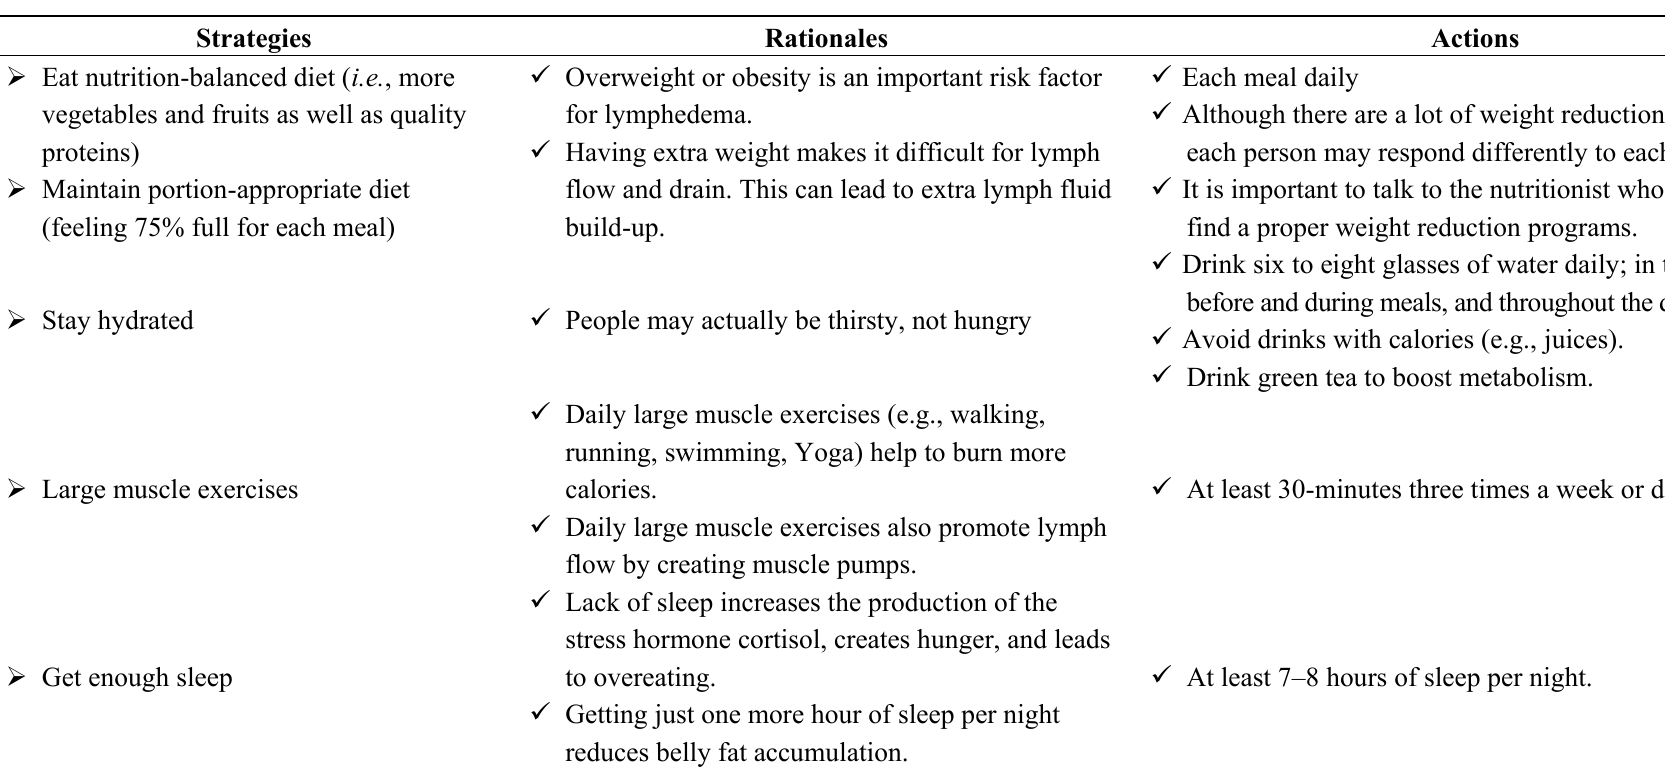
Table 1. The-Optimal-Lymph-Flow TM : Keep a healthy